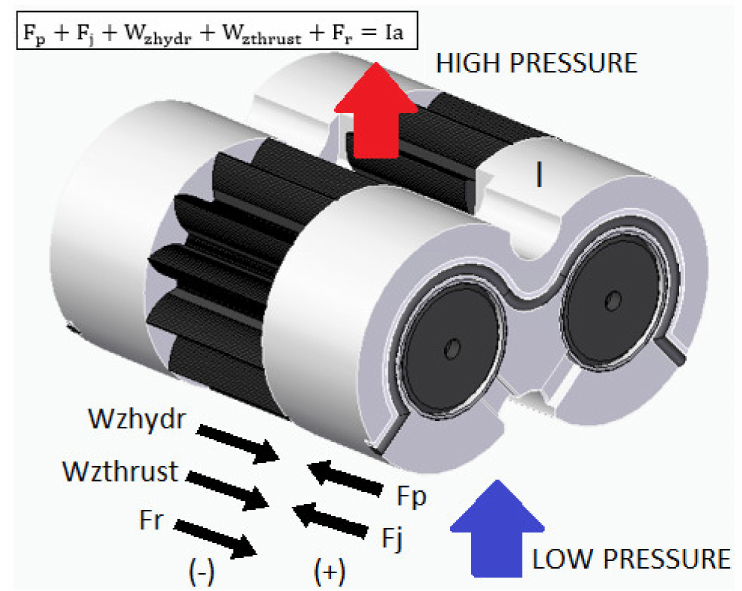
Figure 2. Balancing forces on the floating